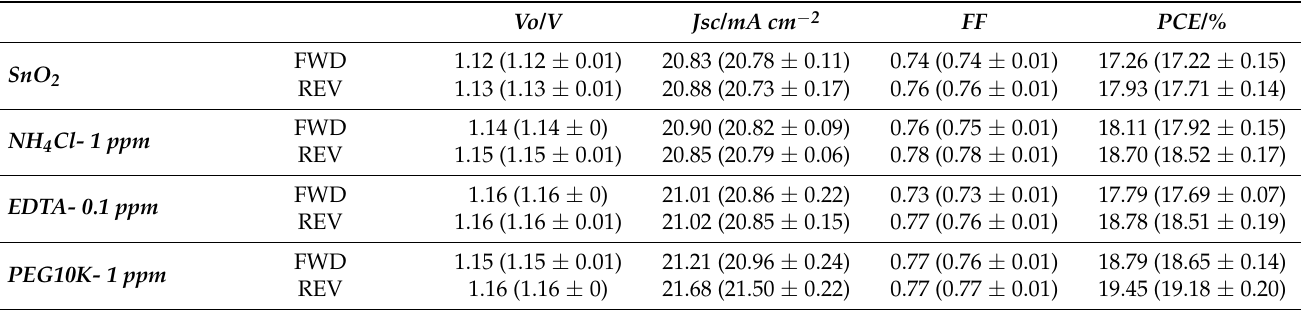
Table 1. Summary of J-V characteristics of perovskite solar cells with ETL spin coated using synthe- sized pristine SnO 2 ink or with NH 4 Cl (1ppm), EDTA (0.1ppm), and PEG10K (1ppm)